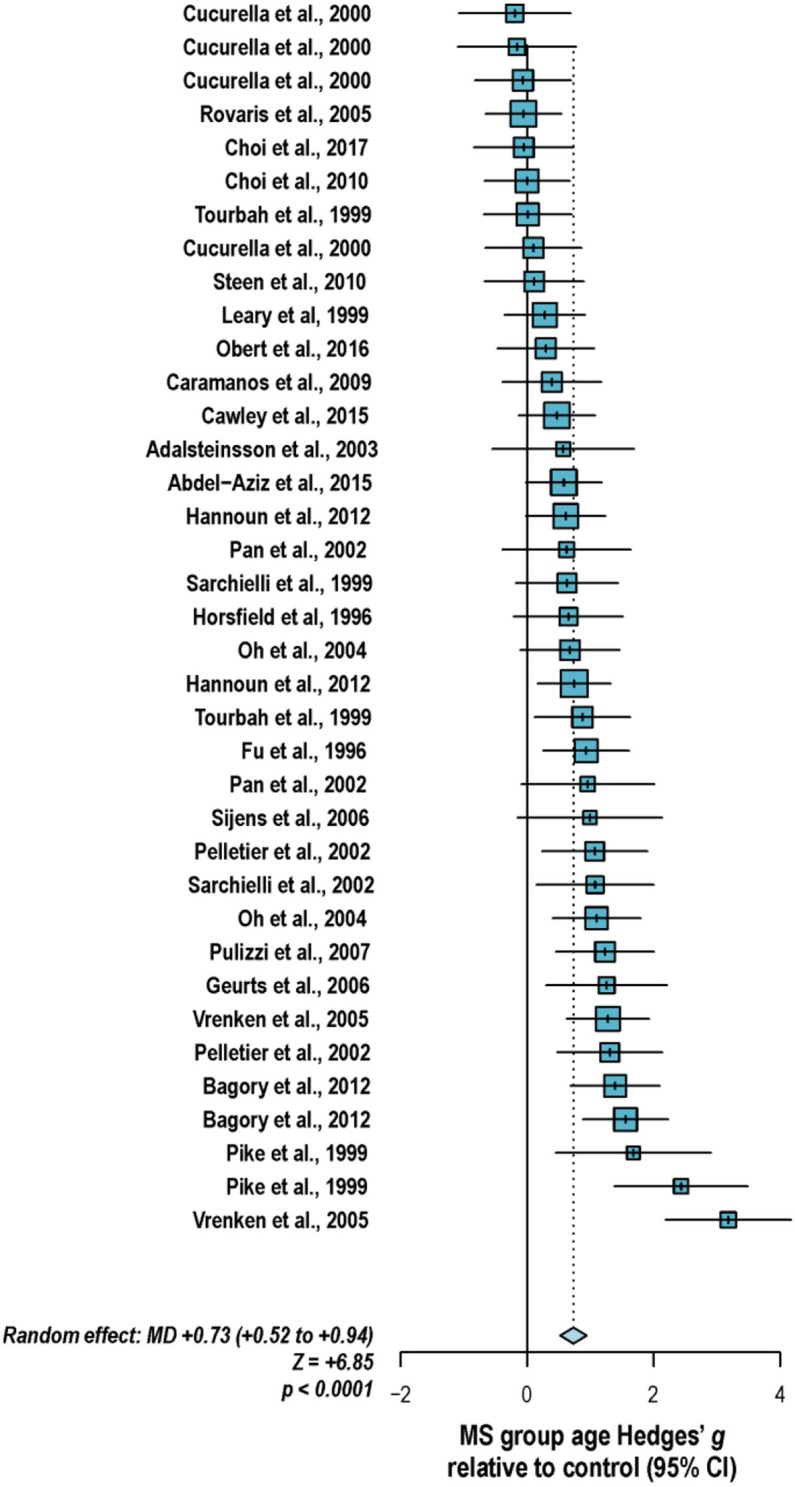
Cross-sectional analyses of progressive multiple sclerosis published between 1996 and 2017 have reported comparing patient groups with age-matched or substantially younger control groups. Shown are the mean differences between multiple sclerosis patient and control groups of 37 1H-MRS studies published between 1996 and 2017 that report means as well as standard deviations and/or range for group ages examining metabolic differences in the brain and/or spinal cord between individuals with and without primary progressive, secondary progressive, progressive relapsing or chronic progressive, or mixed progressive subtypes of multiple sclerosis. A random-effects model exhibited a significant effect of group on subject age across the 37 comparisons, with an overall Hedges' g of +0.73 ± 0.21 (mean difference +6.7 ± 1.9 years) and significance level of p < 0.0001. Many analyses attempted to compensate for such age differences in their statistical modeling procedures. Marker area weighted by group size. MS: multiple sclerosis; MD: standardized mean difference, reported as Hedges' g; CI: confidence interval.